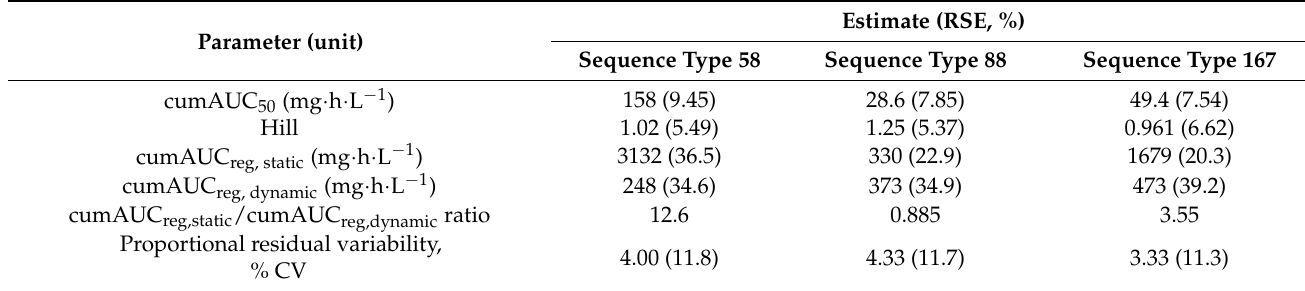
Table 2. Parameter estimates and parameter imprecision of a sigmoidal E max model combined with an inhibition term, describing the exposure–effect relationship of levofloxacin against three clinical Escherichia coli isolates in static and dynamic in vitro infection model